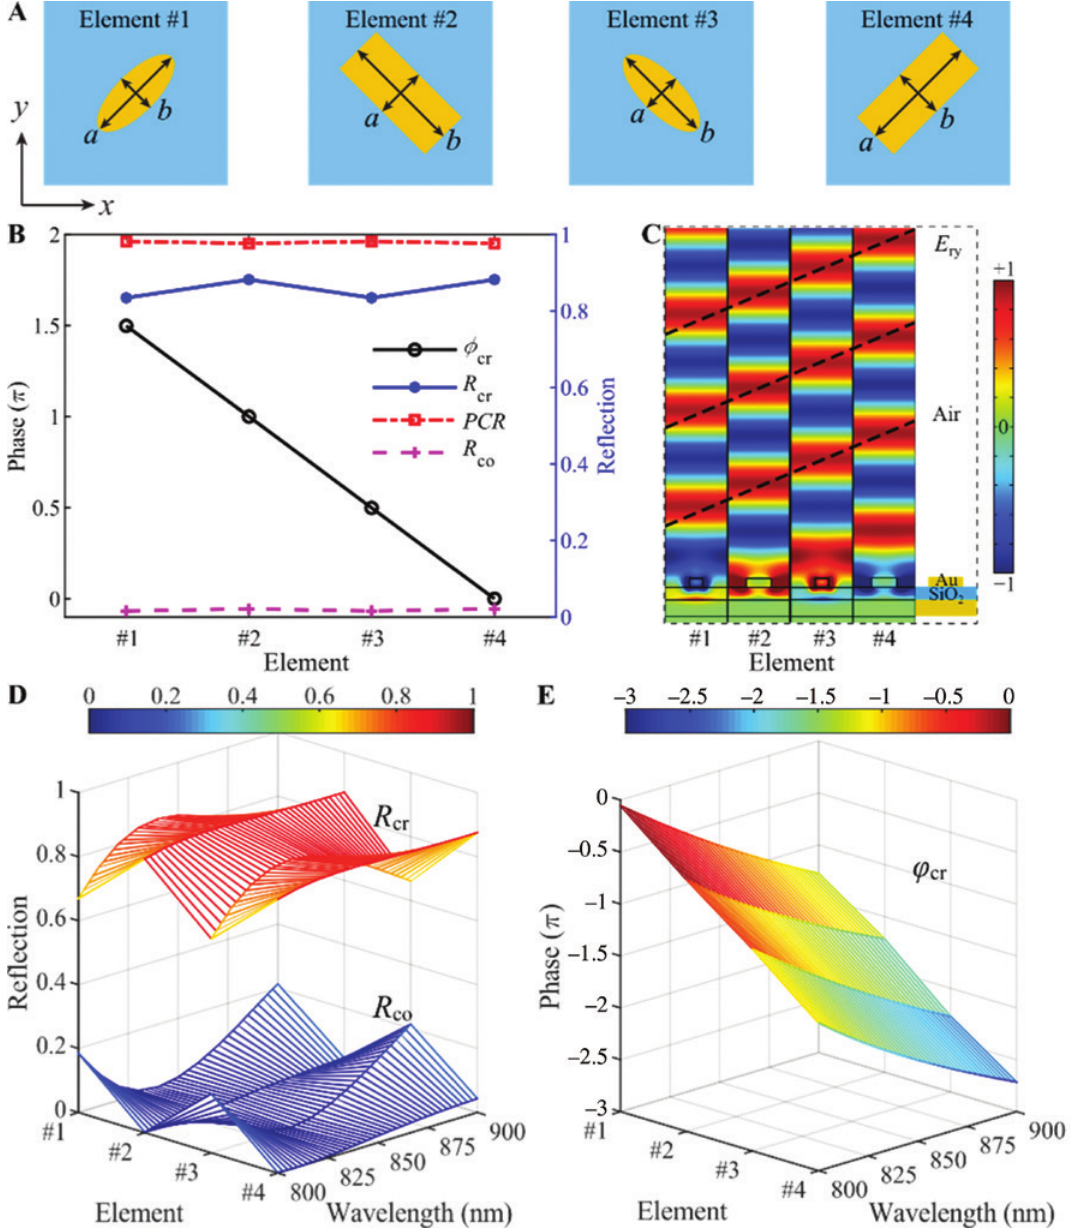
Figure 2: Reflection amplitude and phase responses of the selected meta-atoms. (A) Schematic of the four meta-atoms. The dimensions of element 1–4 are (1) a = 228 nm, b = 90 nm; (2) a = 155 nm, b = 360 nm; (3) a = 90 nm, b = 228 nm; (4) a = 360 nm, b = 155 nm, indicating that elements 3 and 4 are simply rotated by 90 ° with respect to elements 1 and 2, respectively. (B) Simulated cross-polarized reflection phase ϕ linear-polarization conversion ratio PCR of the four elements at λ = 850 nm when an x -polarized plane wave is incident from the top. (D, E) Simulated cross-polarized reflectivity R λ d R , and cross-polarized reflection phase ϕ co